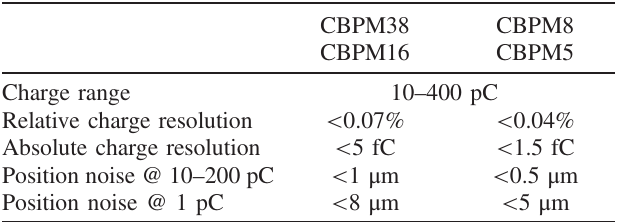
TABLE III. Measured CBPM charge limits and position noise.